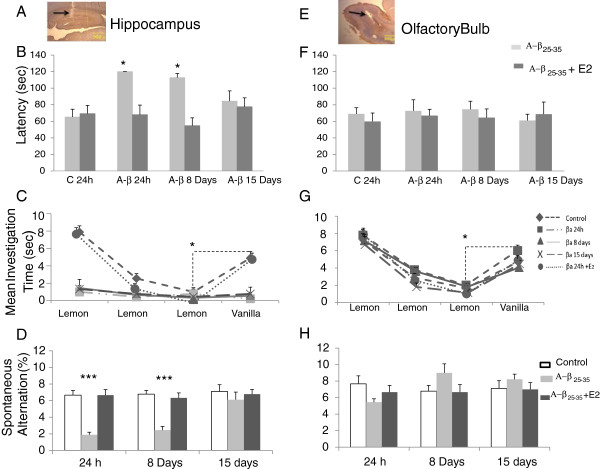
Behavior test. A and E, Microphotography of HIPPO and OB shows the cannula trajectory (4X). B and F, Graphs show the latency to find the piece of buried chocolate of ovariectomized animals tested 24 h, 8 and 15 days after HIPPO (B) or OB injection (F). A-β25-35 injection alone (grey columns). Treatment with E2 (black columns). C and G, Graph shows mean investigation time(s) invested by ovariectomized animals to habituate/dishabituate to lemon and vanilla odors, experimental groups tested at 24 h, 8 and 15 days after A-β injection in HIPPO and a group received E2 + A-β (C, graph) or OB (G, graph). D and H, Graphs show percentage of spontaneous alternation triplets in a T-maze of same experimental (grey columns, A-β groups, black columns A-β + E2 treatment) and control groups, white columns. *P < 0.05, ***P < 0.001.